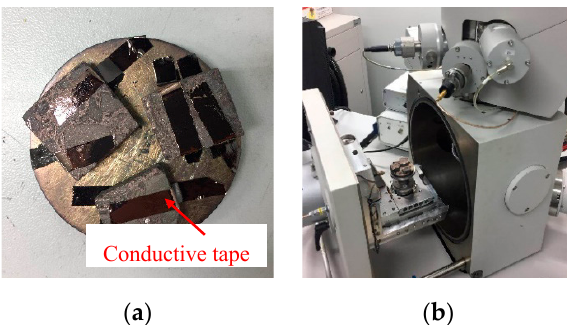
Figure 6. Morphology investigation using SEM. ( a ) Test samples for SEM, and ( b ) SEM equipment.